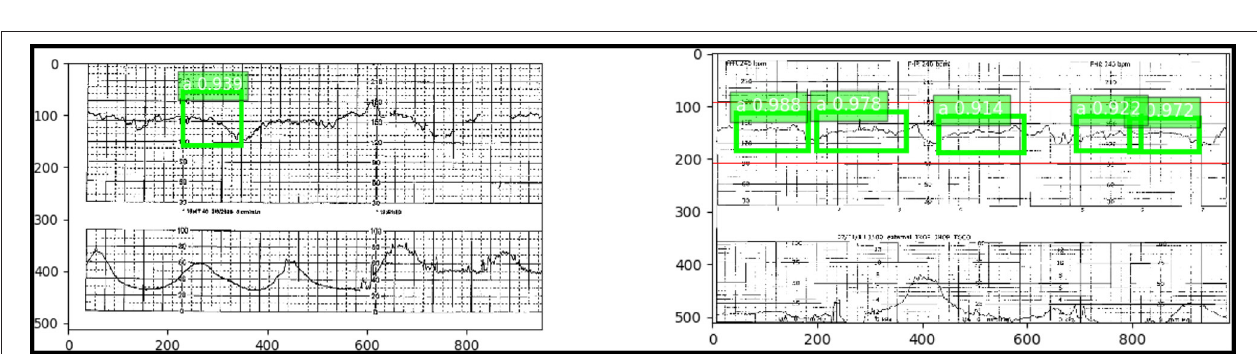
FIGURE 2 | Definition of Point A and Point B. (Top) A representative raw CTG tracing. (Bottom) The annotated CTG tracing deriving Point A and Point B. See Tables 1, 2 for details.